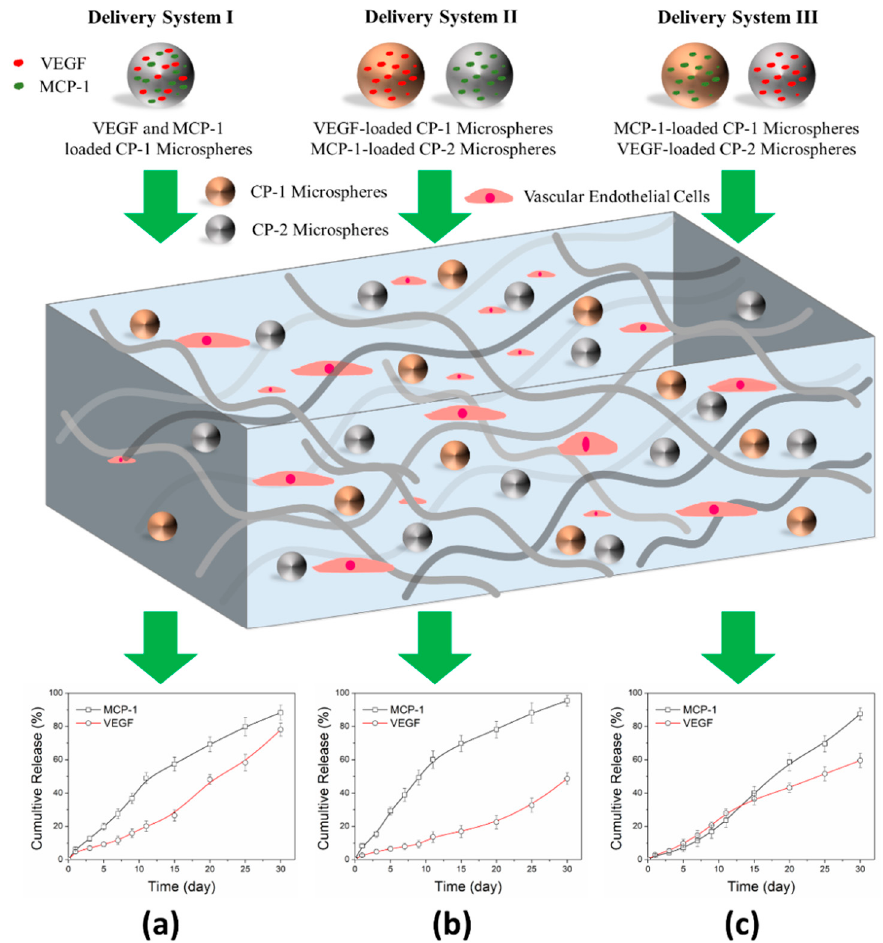
Figure 1. The schematic illustration for the preparation of composite hydrogel by using the VEGF and MCP-1 simultaneous delivery system (different release profiles of growth factor depend on time) and encapsulating VECs. Different microspheres loaded with VEGF and MCP-1 were composited into a star-shaped block copolymer solution (using simulation body fluid), at the same time, VECs were added into, then cells-laden composite hydrogel was formed at 37 °C. ( a ) VEGF and MCP-1 release profiles from delivery system I; ( b ) VEGF and MCP-1 release profiles from delivery system II; ( c ) MCP-1 and VEGF release profiles from delivery system III.